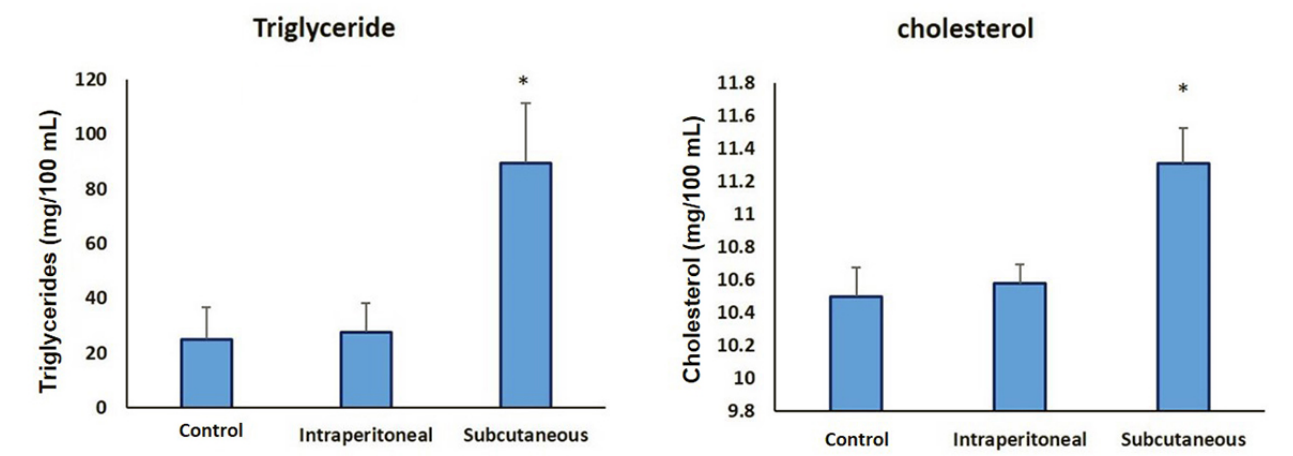
Figure 1. Levels of cholesterol and triglycerides in different rat groups, namely, control, intraperitoneal SAV-injected and subcutaneous SAV-injected rats.